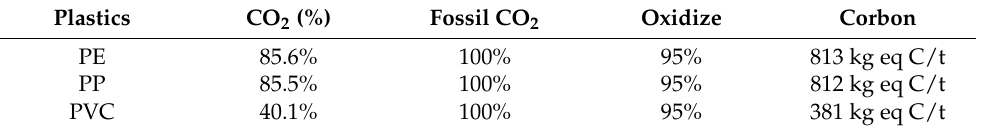
Table 6. Release of Corban Dioxide of Plastic: Used as per Elsevier Permission [92].